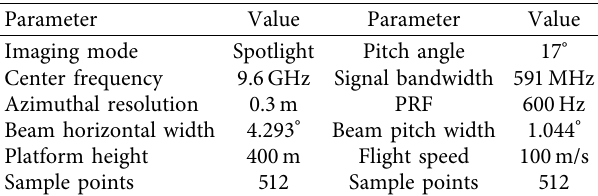
Figure 2: Geometric models of the three vehicles. (a) BMP2; (b) BTR70; (c) T72. Table 1: Spotlight SAR simulation parameters of vehicle